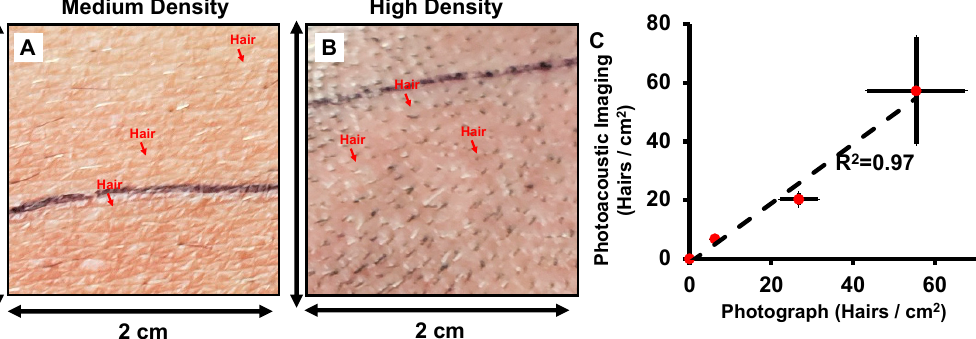
Figure 6. Quantification of follicle density. ( A , B ) Photograph of 2 × 2 cm 2 of medium-density (abdomen) and high-density (scalp) areas. ( C ) Correlation between follicle density measurement using photoacoustic data and photograph images. High correlation (R 2 = 0.97) is observed between these two techniques.